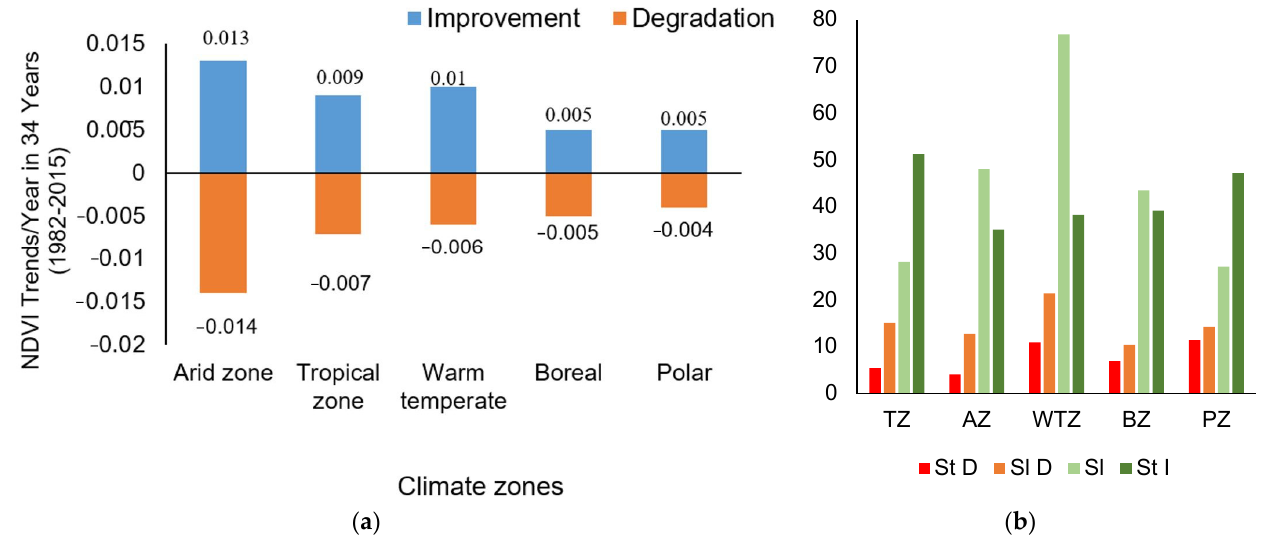
Figure 6. Overall trends in annual NDVI3g in each of the five climate zones of Africa. ( a ) the rate of increase and decrease per year; ( b ) the statistical results’ area in percentage of greening variation from 1982 to 2015, with St D: Strong Degradation, Sl D: Slight Degradation, SI: Slight Improvement and St I: Strong Improvement; AZ: Arid Zone, TZ: Tropical Zone, Wt Z: Warm Temperate, PZ: Polar Zone and BZ: Boreal Zone.